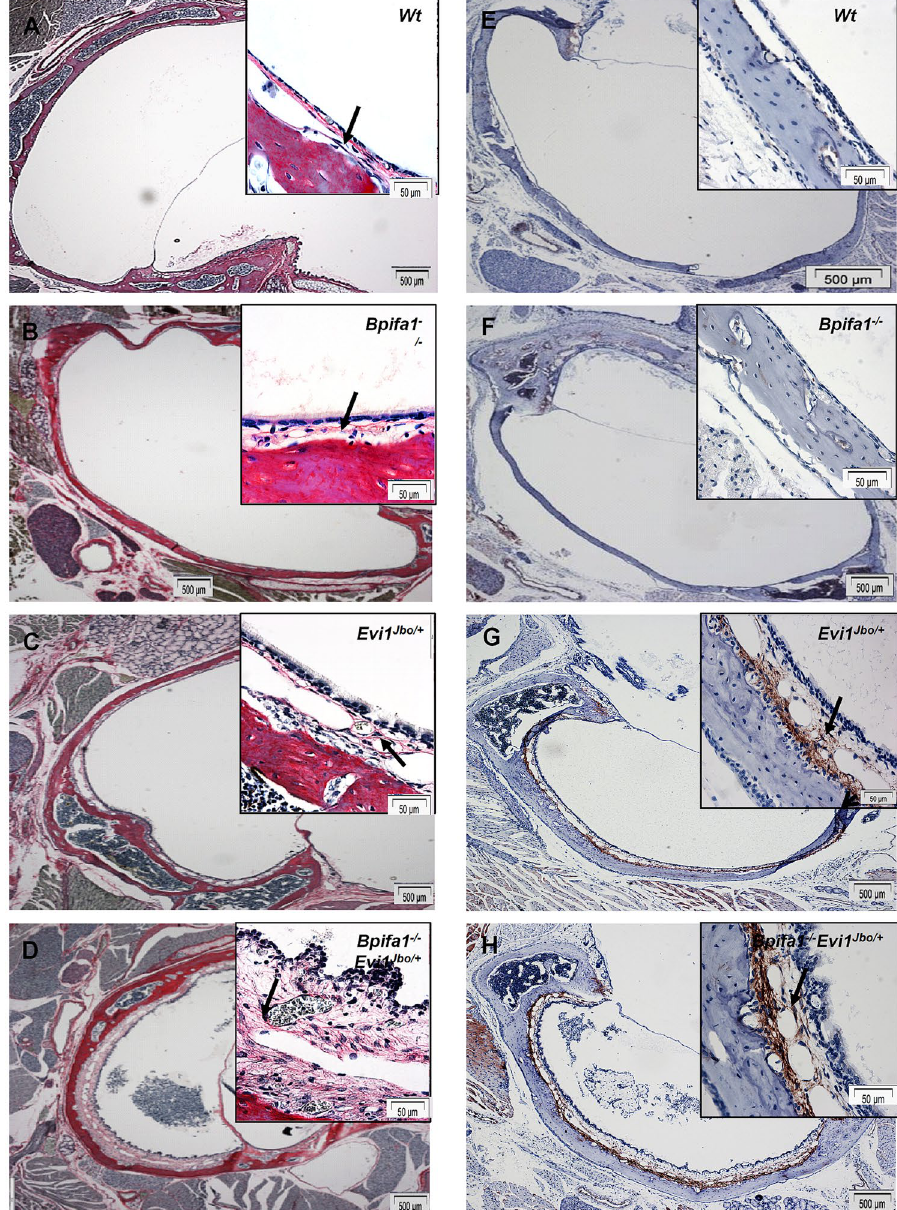
Figure 5. Sub-epithelial fibrosis in Bpifa1 − / − Evi1 Jbo/ + and Evi1 Jbo/ + middle ears. Picrosirius red staining showing collagen fibres in the sub-epithelial connective tissue of WT ( A ) and Bpifa1 − / − ( B ) ME. Staining intensity increases in the inflamed and expanded mesenchyme of Evi1 Jbo/ + ( C ) and Bpifa1 − / − Evi1 Jbo/ + ( D ) ME